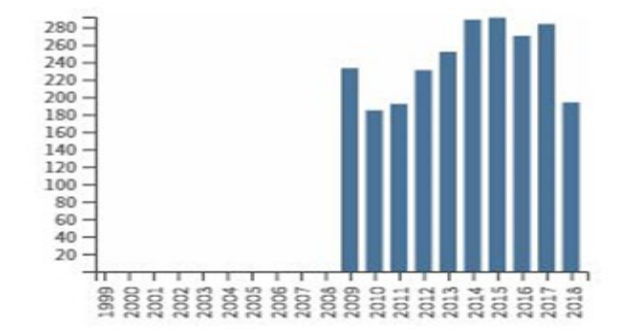
Figure 1-a. Total Publications by Year